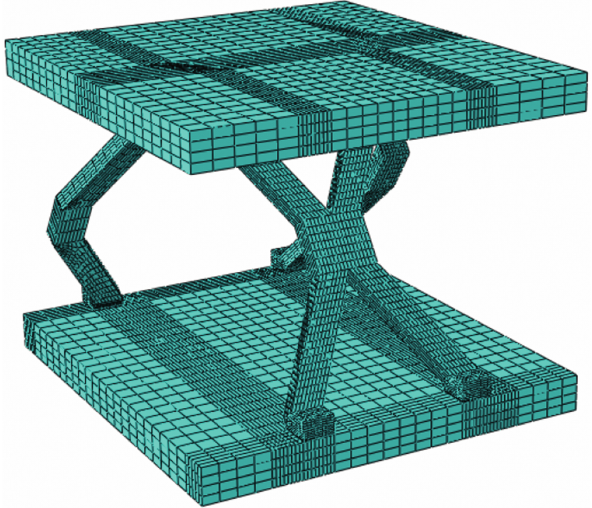
Figure 3: Finite element